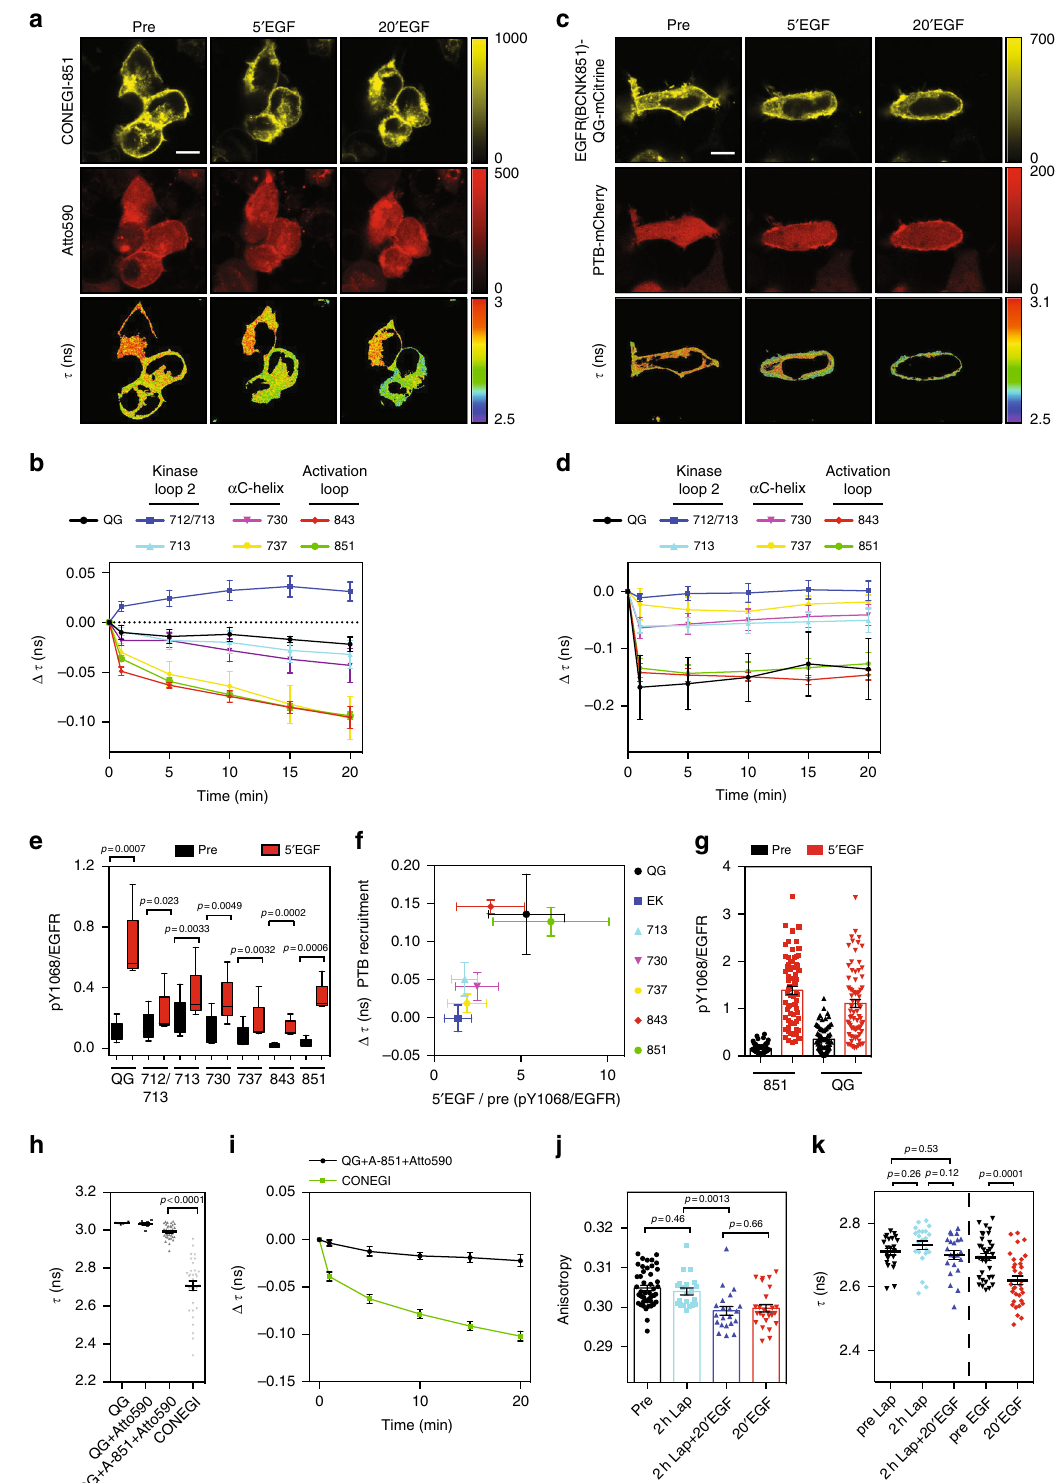
(SEM)) and only marginally decreased upon EGF stimulation (Fig. 2h, i; Supplementary Fig. 2f), showing that FRET in CONEGI reports on intramolecular conformational rearrangements. To demonstrate that the change in FRET ef fi ciency in CONEGI originates from the rearrangement of the activation loop rather than from mCitrine reorientation upon dimerization, we locked